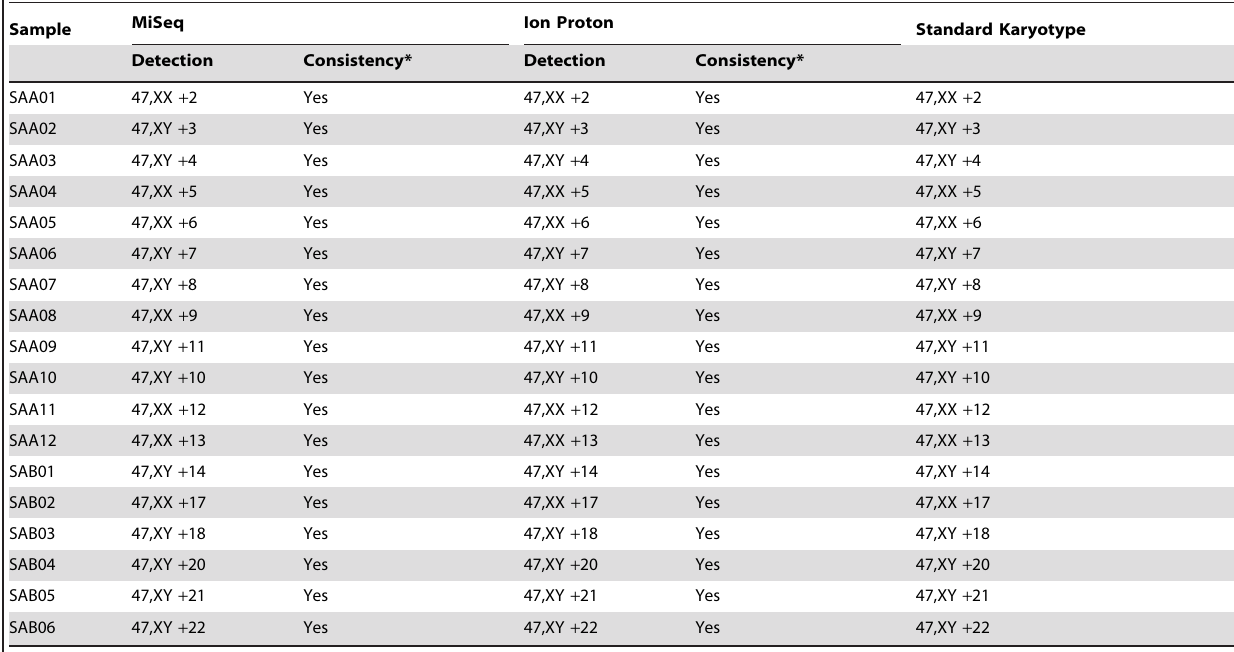
Table 2. Aneuploidy Detection results using UCLS.